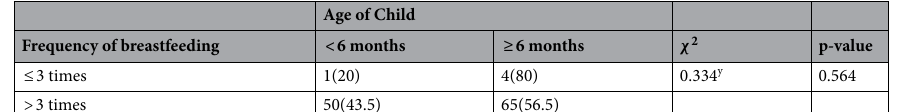
2 : Chi-square test; y : Yate’s